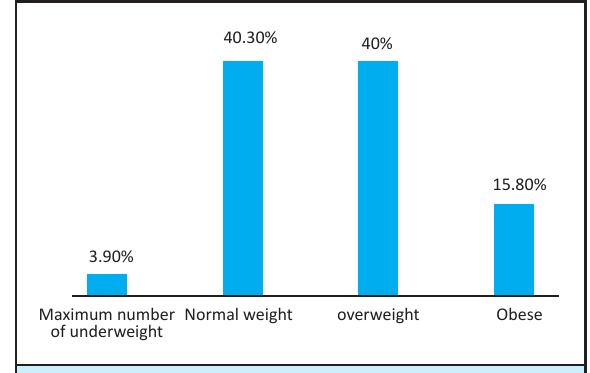
Figure 1. BMI status of the